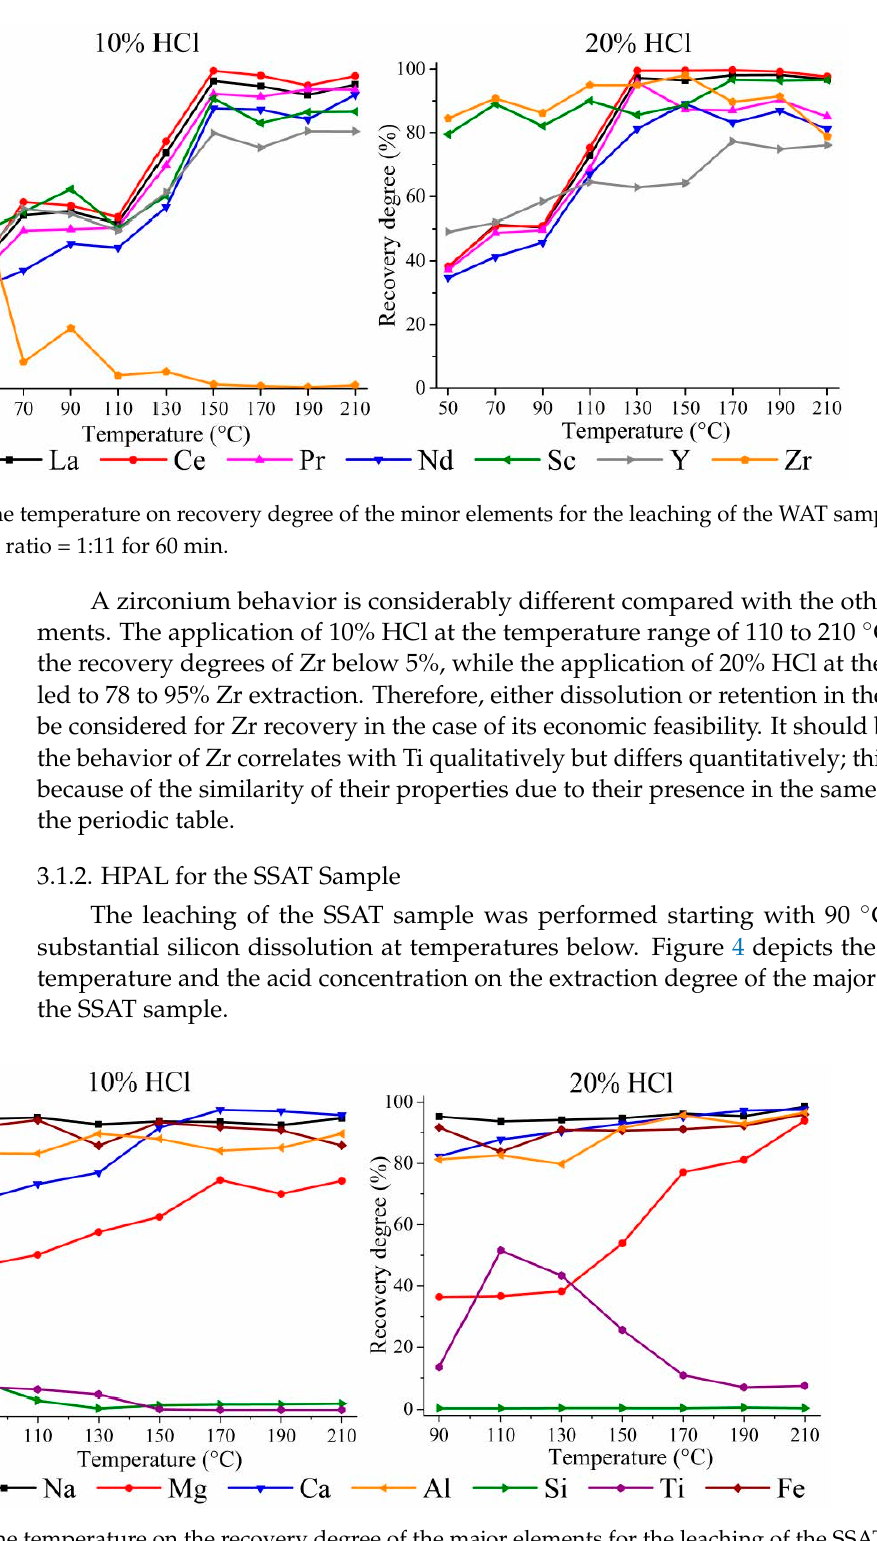
Figure 4. The effect of the temperature on the recovery degree of the major elements for the leaching of the SSAT sample using 10% and 20% HCl at S:L ratio = 1:11 for 60 min.